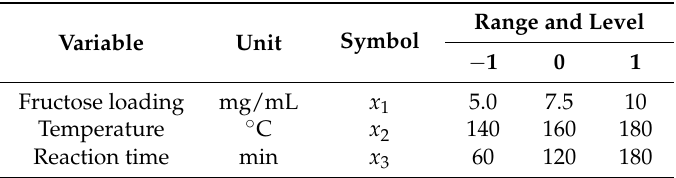
Table 5. Range and levels of independent variables.